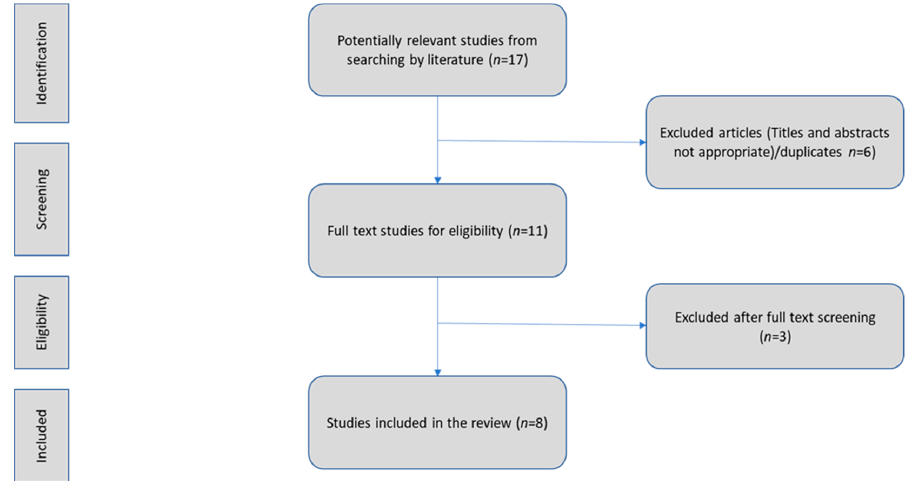
Figure 2. Flow chart. Identification and selection of the studies.